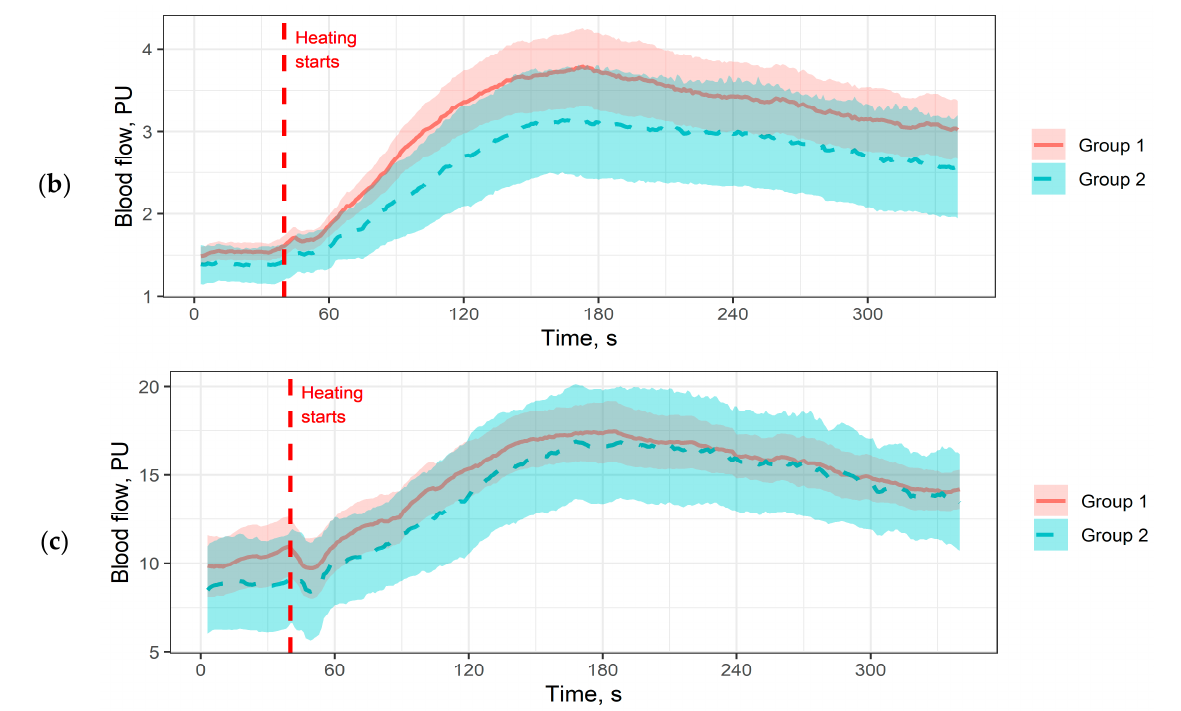
Figure 1. Averaged perfusion plots. The coloured area denotes 95% confidence intervals. ( a ) Perfusion plot for the occlusion test on the index finger; ( b ) Perfusion plot for the local thermal test on the dorsal surface of the foot; ( c ) Perfusion plot for the local thermal test on the big toe. Pressure measurement periods and pauses are cut out for plot matching.